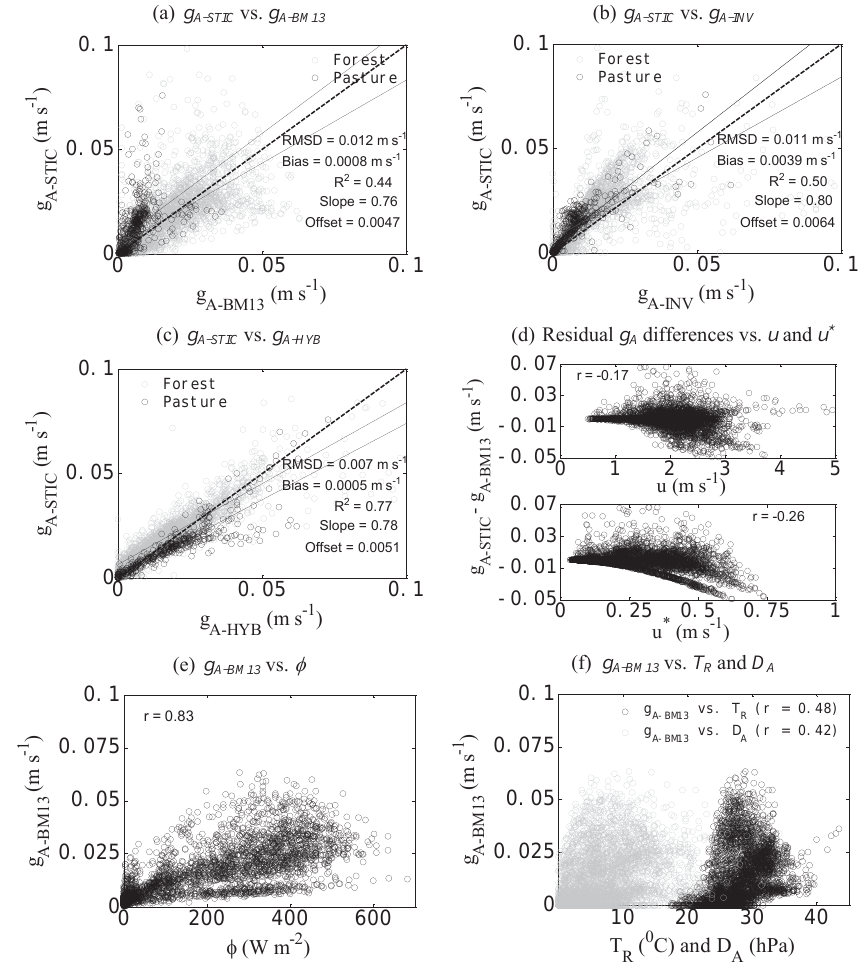
Figure 2. (a) Comparison between STIC-derived g A ( g A-STIC ) with an estimated aerodynamic conductance based on friction velocity ( u ∗ ) and wind speed ( u ) according to Baldocchi and Ma (2013) ( g A-BM13 ), (b) comparison between g A-STIC with an inverted g A ( g A-INV ) based on EC observations of λE and D A , (c) comparison between g A-STIC with a hybrid g A ( g A-HYB ) based on EC observations of H and estimated T 0 over the LBA EC sites, (d) comparison between residual g A differences vs. u and u ∗ , and (e, f) relationship between wind- and shear-derived g A vs. φ , T R , and D A over the LBA EC sites.